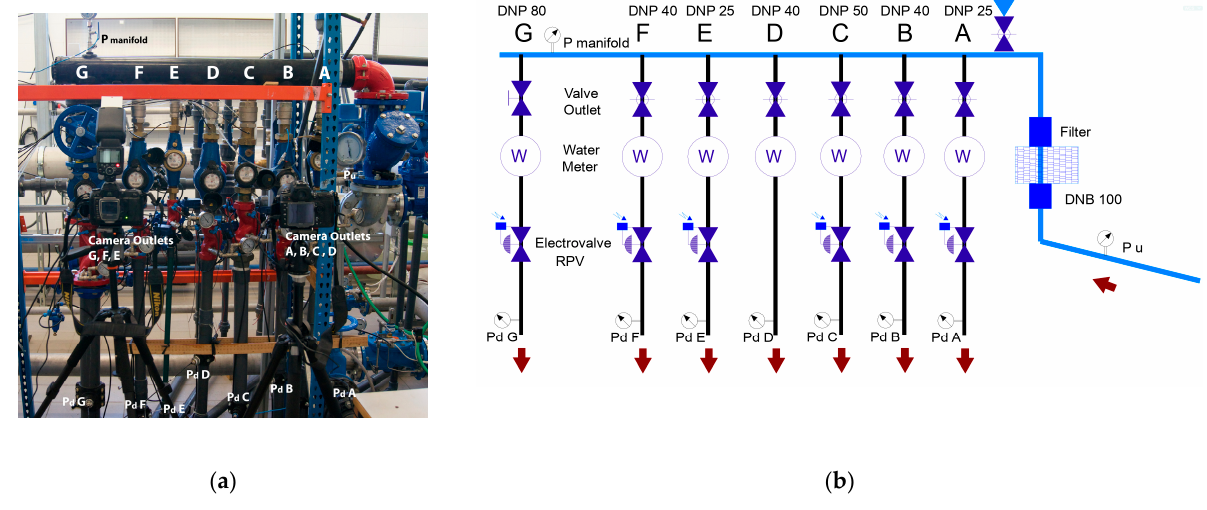
Figure 7. ( a ) Metrological test for multioutlet hydrant number 11 (V1/Type 3-10/DNB100-QNB 112-DNP 25 x2 40 x3 50 x1 80 x1/PN6). Specific outlet diameters A: DNP 25; B: DNP 40; C: DNP 50; D: DNP 40; E: DNP 25; F: DNP 40; G: DNP 80; ( b ) Accuracy test scheme for hydrant number 11.